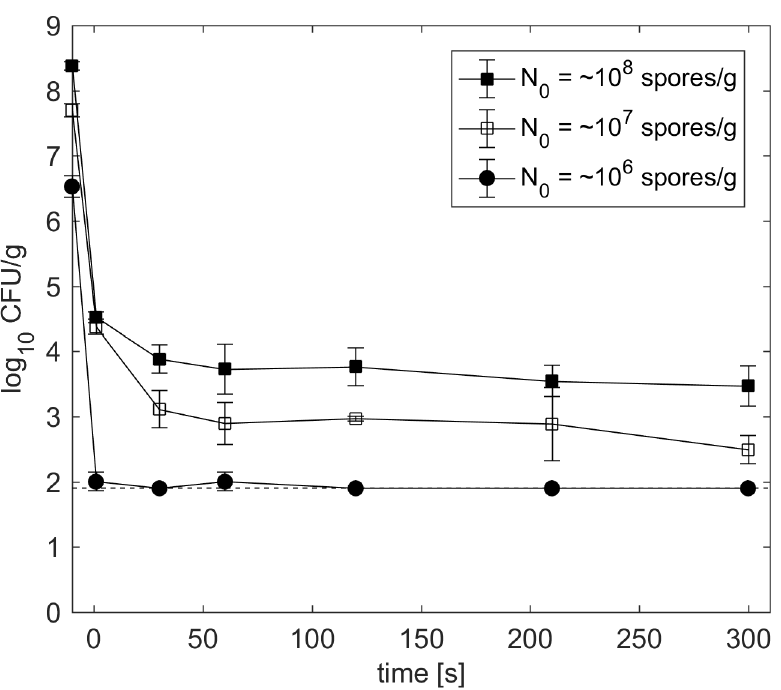
Fig 4. Viable spores (CFU/g) of C . botulinum TMW 2.357 at 600 MPa and 110˚C in green peas with ham. Different symbols indicate different initial spore counts, i.e., 10 6 (circles), 10 7 (open squares) and 10 8 (solid squares)spores/g. The dashedline represents the detectionlimit (log 10 CFU/g: 1.9). Data are shown as means ± standard deviations of triplicate independentexperiments.